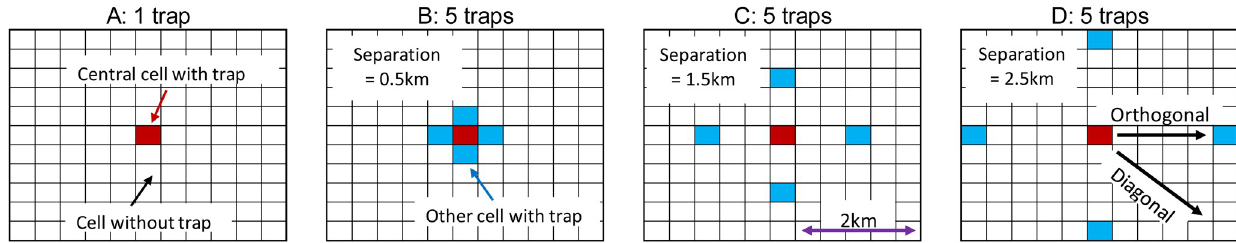
Fig 1. A-D: Various arrangements of traps in an 11 x 11 cell block at the middle of a map of 71 x 71 cells. The separation distance shown for each arrangement is the distance between a trap and its closest neighbour. That distance is half the greatest distance between traps in present arrangements. Arrows in D show what is meant in the main text by the “orthogonal” and “diagonal” directions of movement away from the central cell.